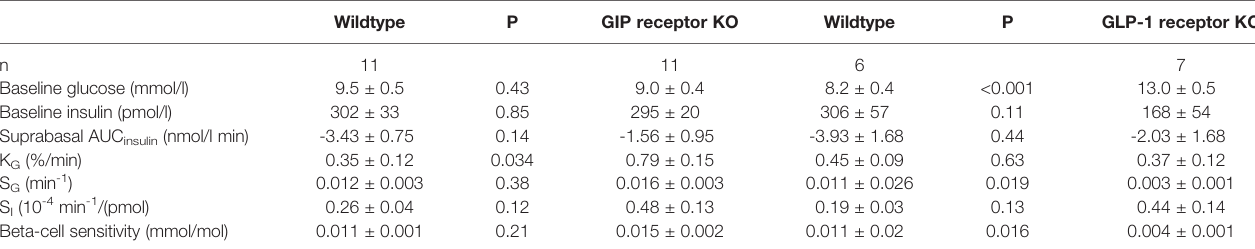
TABLE 2 | Baseline glucose and insulin, suprabasal area under the 50 min curve (AUC) of glucose and insulin, glucose elimination rate (K G ), glucose effectiveness (S G ), insulin sensitivity index (S